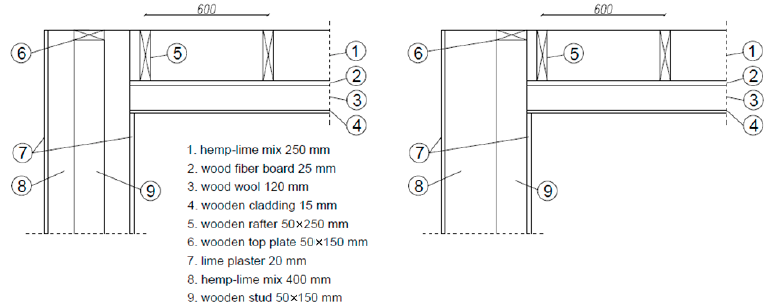
Figure 6. Connection of the gable wall and roof in two cases: with the timber frame located centrally in relation to the wall thickness (on the left ) and located on the inner side of the wall (on the right ).